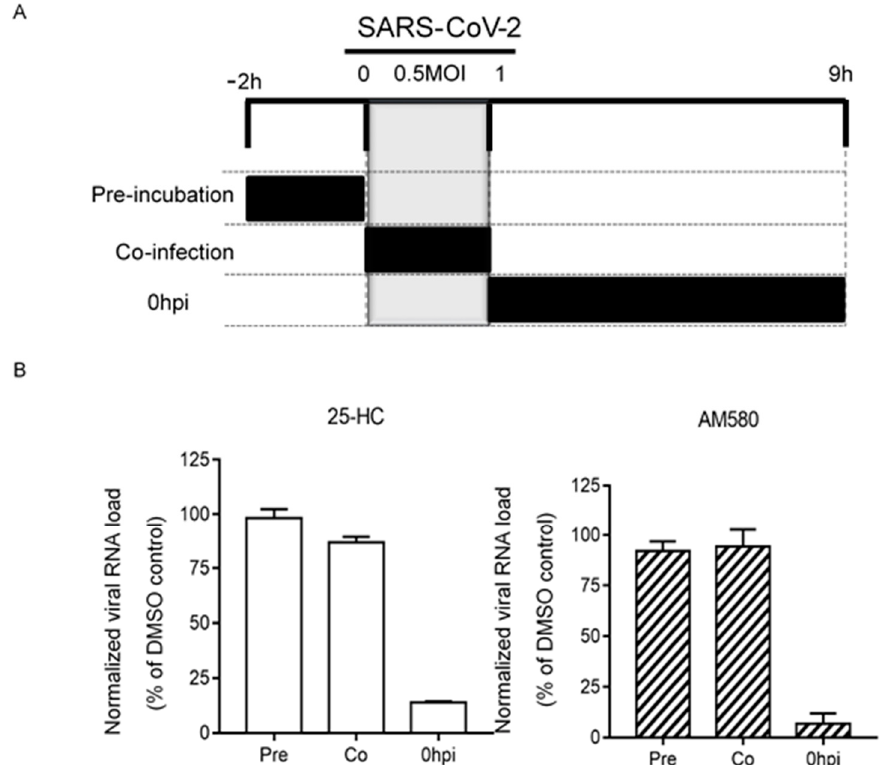
Figure 5. Time-of-drug-addition assay for 25-HC and AM580. ( A ) Schematic representation of the experimental design of time-of-drug-addition assay. The grey blocks indicate the duration of virus adsorption and the black blocks represent the incubation periods between the cells and individual compounds. ( B ) The viral loads in the culture supernatants normalized by DMSO at the different phases of the assay were shown. The experiments were performed in triplicate and replicated twice. The results are shown as mean ± standard deviations. Abbreviation: 25-HC, 25-hydroxycholesterol.